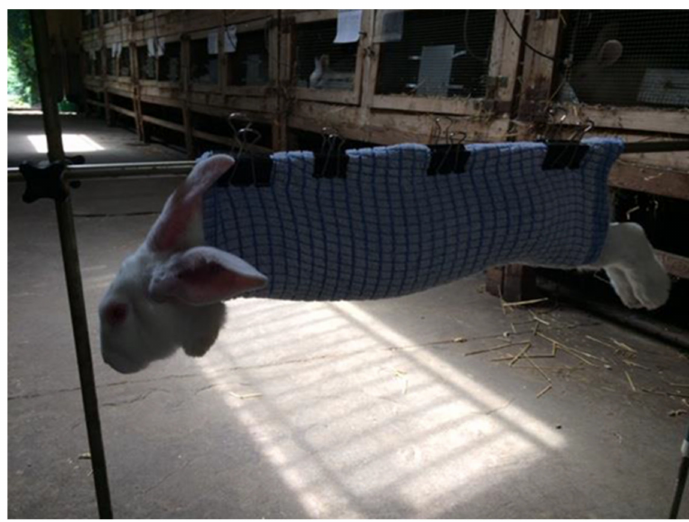
Figure 1. The method of inducing a stress reaction in a rabbit (photo by the